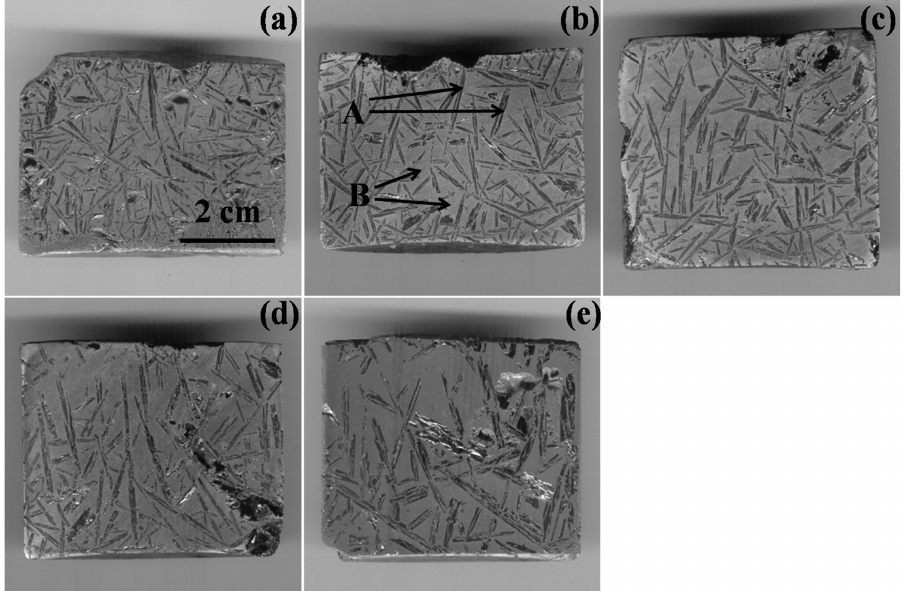
Figure 3: Scanning images of cross sections of the Al-40% Si with different cooling rates (a, b, c, d, and e cooled at 46.78, 19.49, 6.50, 2.44 and 0.81 mK/s